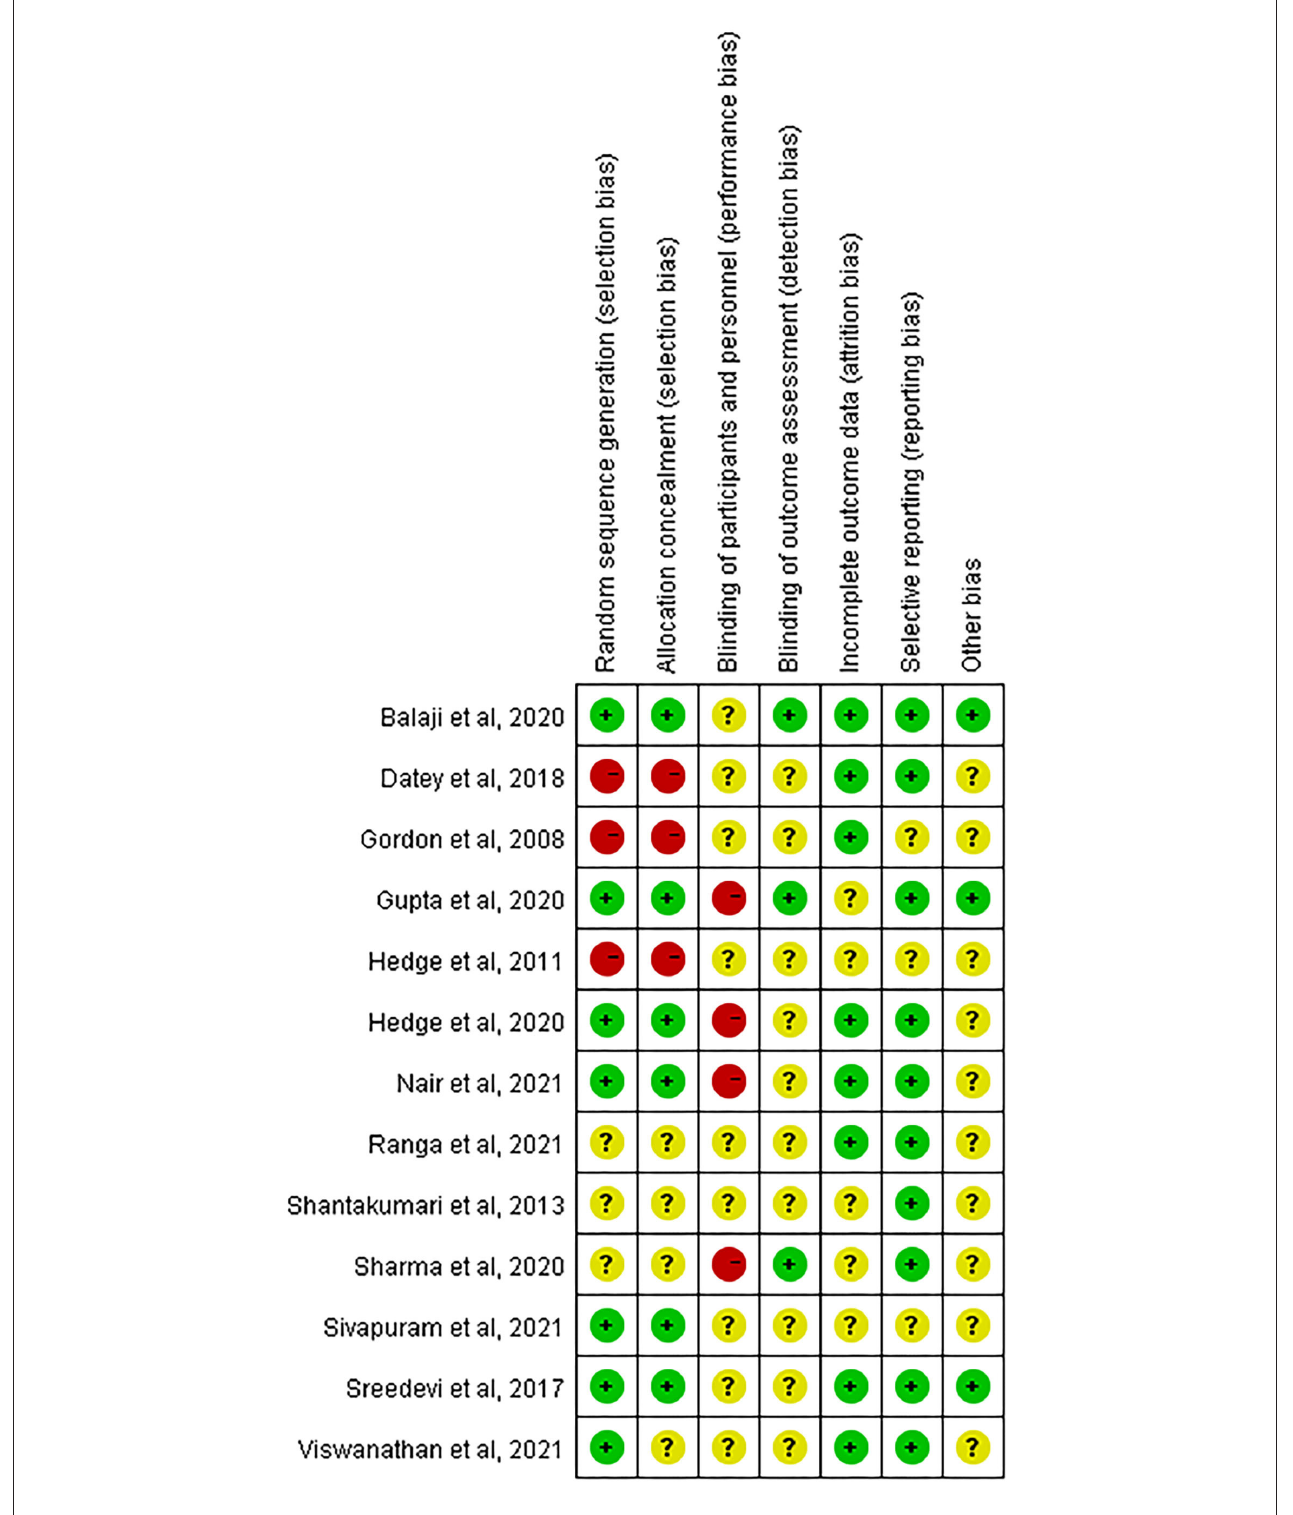
FIGURE 3 | Risk of bias summary: judgment on each risk of bias item for each included study.